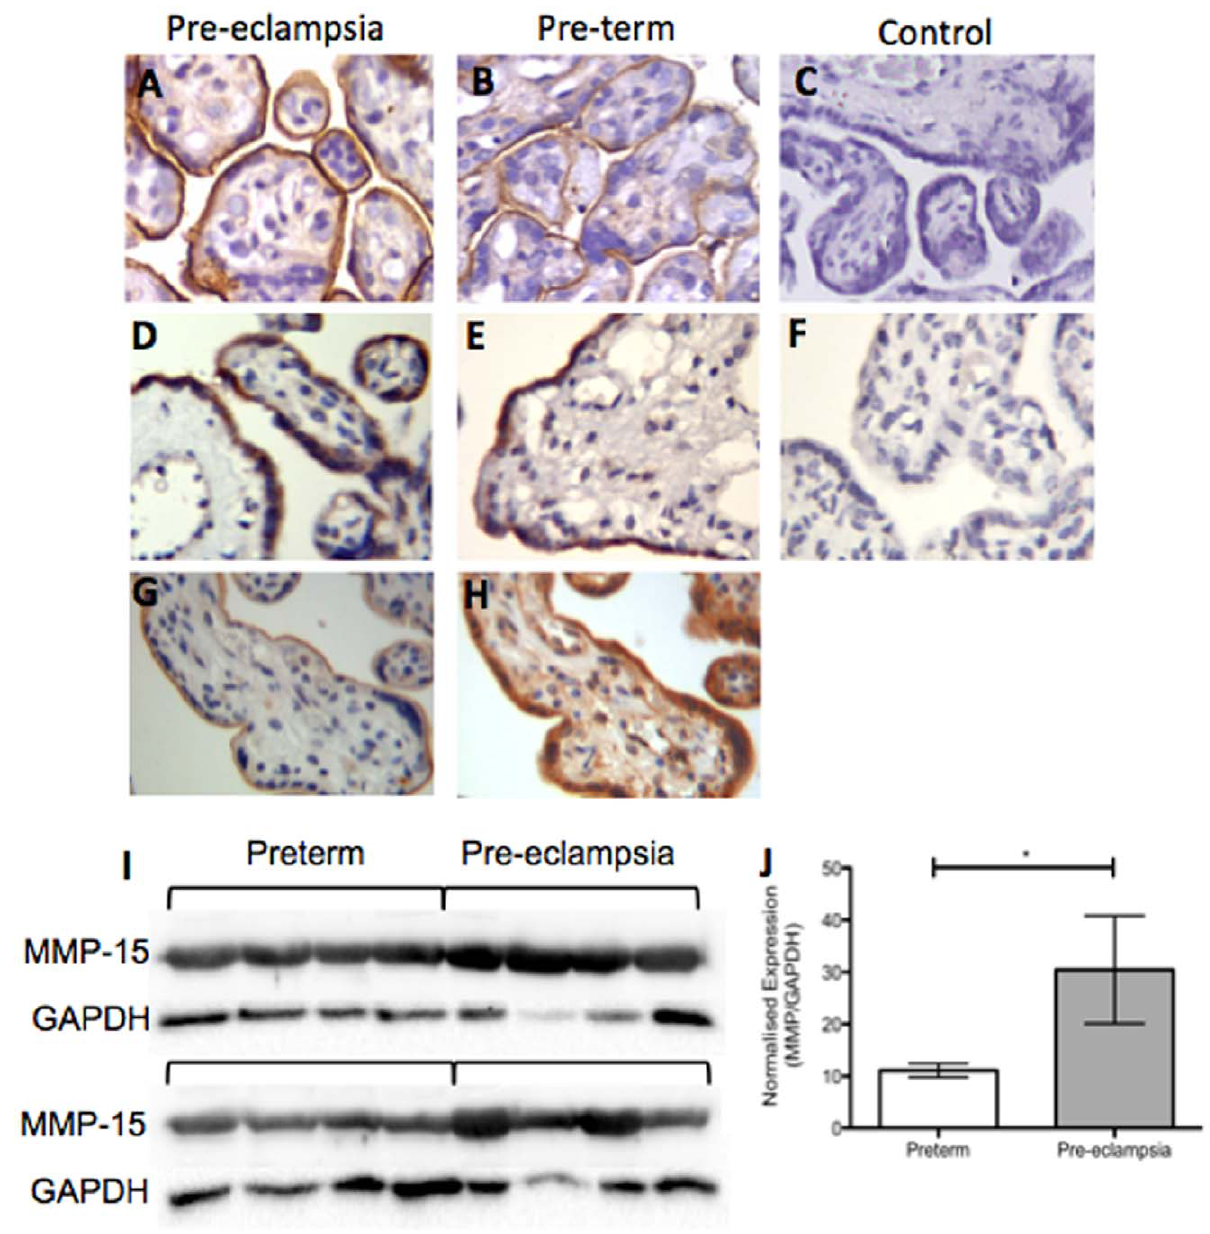
Figure 1. MMP-15 is localised to the syncytiotrophoblast and up-regulated in preeclamptic placenta. Representative immunohisto- chemistry for endoglin ( A, B ) and MMP-15 ( D, E ), shows both proteins localize to the syncytiotrophoblast in pre-eclamptic ( A, D ) and pre-term control ( B, E ) placentas. Immunohistochemistry on serial sections (2 m m) of placenta revealed co-localisation of endoglin ( G ) and MMP-15 ( H ) to the syncytiotrophoblast. No staining was observed in isotype controls ( C, F ). Densitometric analysis of western blots for MMP-15 ( I, J ) revealed a significant increase in preeclamptic placentas (n=8) compared to pre-term controls (n=8). *p # 0.05.